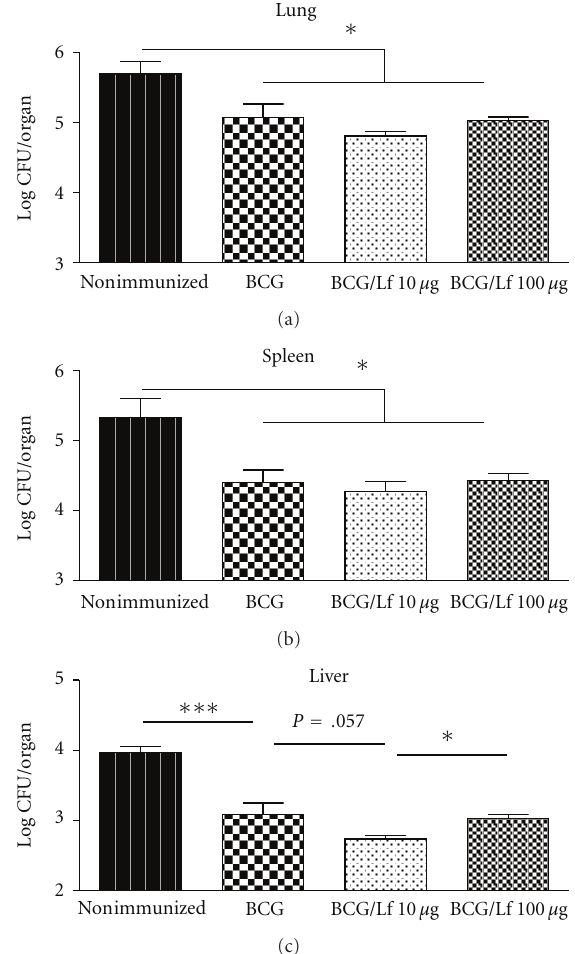
Figure 2: Reduced bacterial loads in BCG-immunized mice after infectious challenge with MTB. C57BL/6 mice were immunized with BCG (1 × 10 6 CFU/mouse; Pasteur strain TMC 1011, ATCC, Manassas, VA) or BCG/bovine lactoferrin (10 or 100 μ g/mouse) and boosted at 8 weeks. One group remained nonimmunized. At 12 weeks postboost, mice were aerosol infected with a low dose (approximately 100 CFU/mouse) Erdman MTB (TMC 107, ATCC) and monitored through day 65 postinfection for organ bacterial load. All vaccinated mice were able to reduce bacterial load in tissue following infectious challenge. Minimum number of animals per group was 6 for controls and 10 for immunized mice. ∗ P < . 05; ∗∗∗ P < .